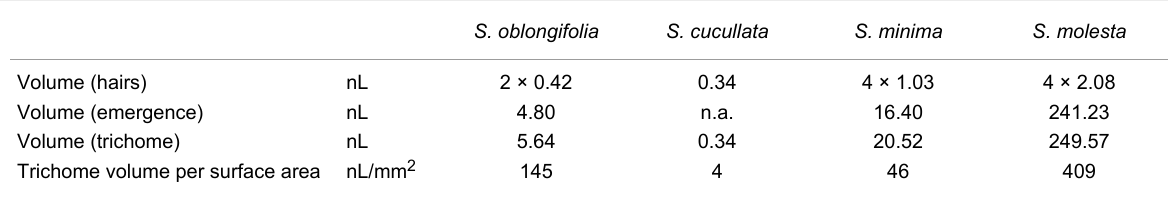
Table 2: Calculated trichome volumes.